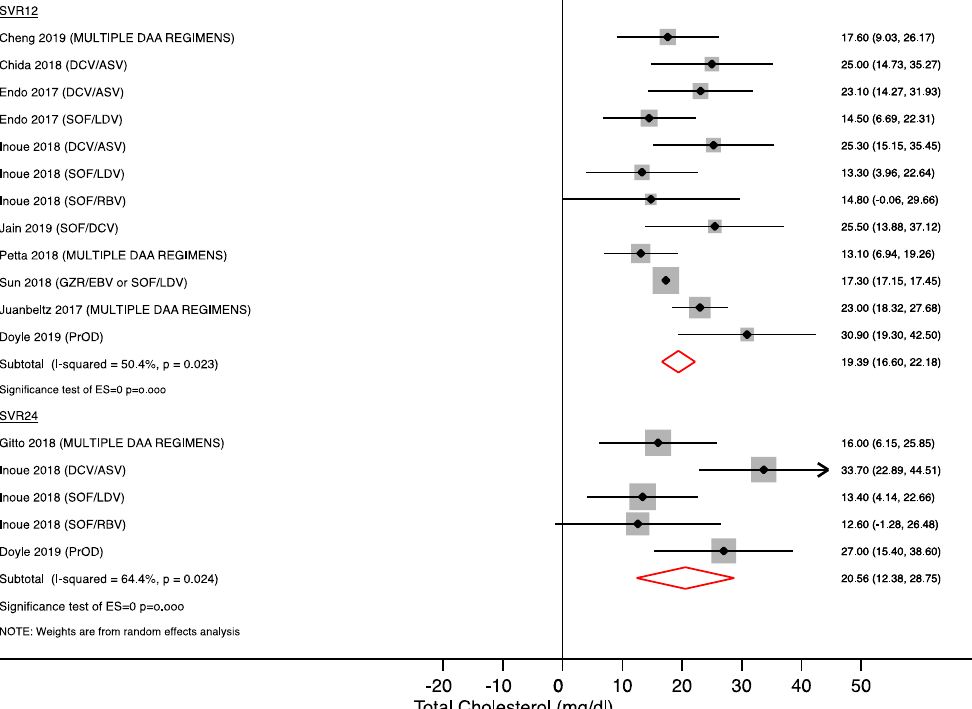
Figure 2. Serum total cholesterol changes after treatment completion. Forest plot for mean difference (MD) and 95% confidence intervals (CI) for each time-point. DCV/ASV daclatasvir/asunaprevir, SOF/LDV sofosbuvir/ ledipasvir, SOF/RBV sofosbuvir + ribavirin, SOF/SMV sofosbuvir/simeprevir, GRZ/EBV grazoprevir/elbasvir, PrOD paritaprevir/ritonavir/ombitasvir + dasabuvir, SVR12 Sustained virological response at 12 weeks; SVR24: Sustained virological response at 24 weeks.